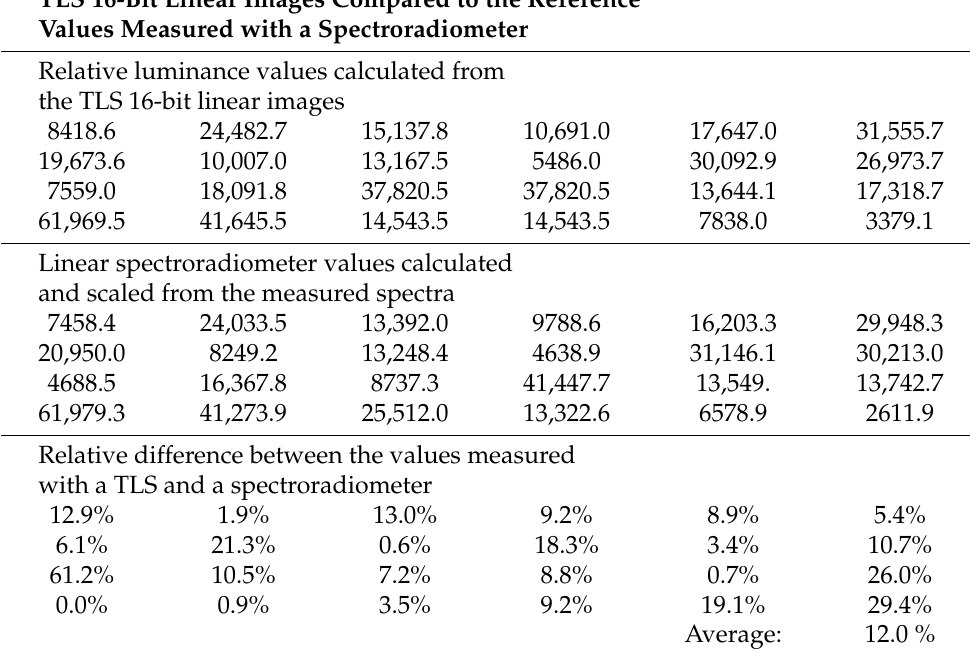
Table 7. The relative luminance values calculated from the TLS 16-bit linear images compared to different sets of reference values. The table presents the values ordered according to the reference color target (Figure 2).